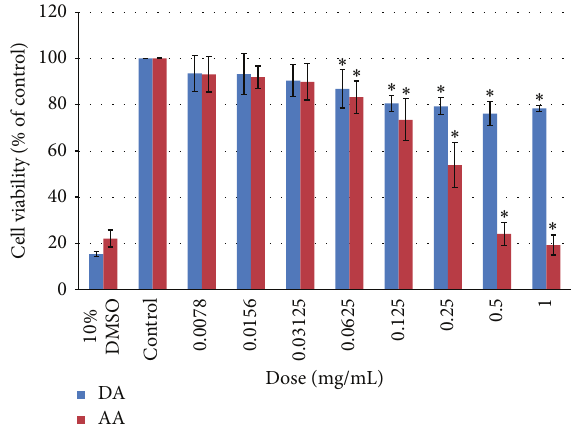
Figure 3: Cellular viability versus monomer dose for the BEAS- 2B cells for a 24-hour exposure. Data is expressed as an average of three independent experiments ± standard deviation for each independent experiment. “ ∗ ” denotes a statistically significant ( 𝑃 < 0.01 ) difference from the unexposed